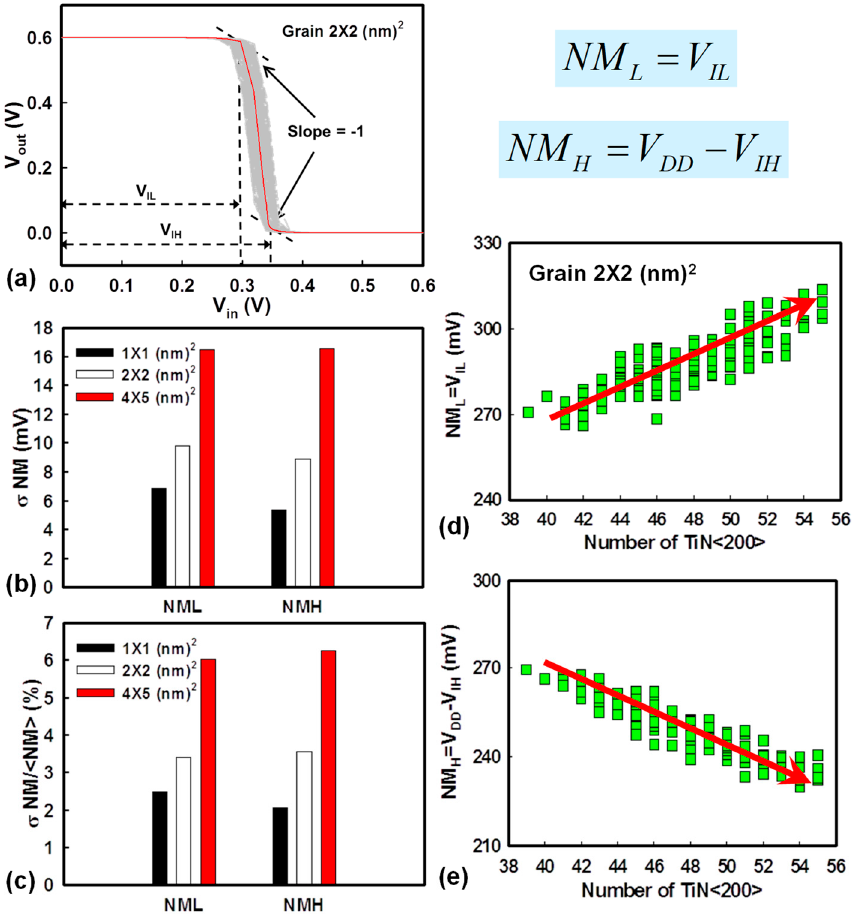
Figure 4. ( a ) The voltage transfer curves of NW MOSFET inverter circuits fluctuated by WKF. V IL and V IH are used to determine the noise margin (NM) of the inverter. The slope at these two points of voltage transfer curves is − 1V/V. The related definitions of low level of noise margin (NML) and high level of noise margin (NMH) are shown below ( a ). ( b ), ( c ) Plots of the fluctuated NM induced by the WKF of a GAA NW MOSFET with three grain sizes: 4 × 5 nm 2 (red), 2 × 2 nm 2 (white), and 1 × 1 nm 2 (black), respectively. ( b ) The standard deviation and ( c ) the coefficient of variance of NM. ( d ), ( e ) Plots of NML and NMH versus the number of TiN <200> with grain size equal to 2 × 2 nm 2 . The trend of NM versus high WK number between NM L and NM H acts conversely. When the high WK number increases, NM L also increases, and thus, NM H decreases.